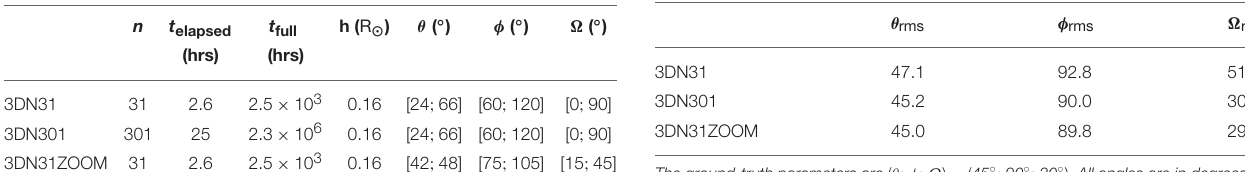
TABLE 1 | Characteristics of the test with a likelihood function possessing a single maximum.